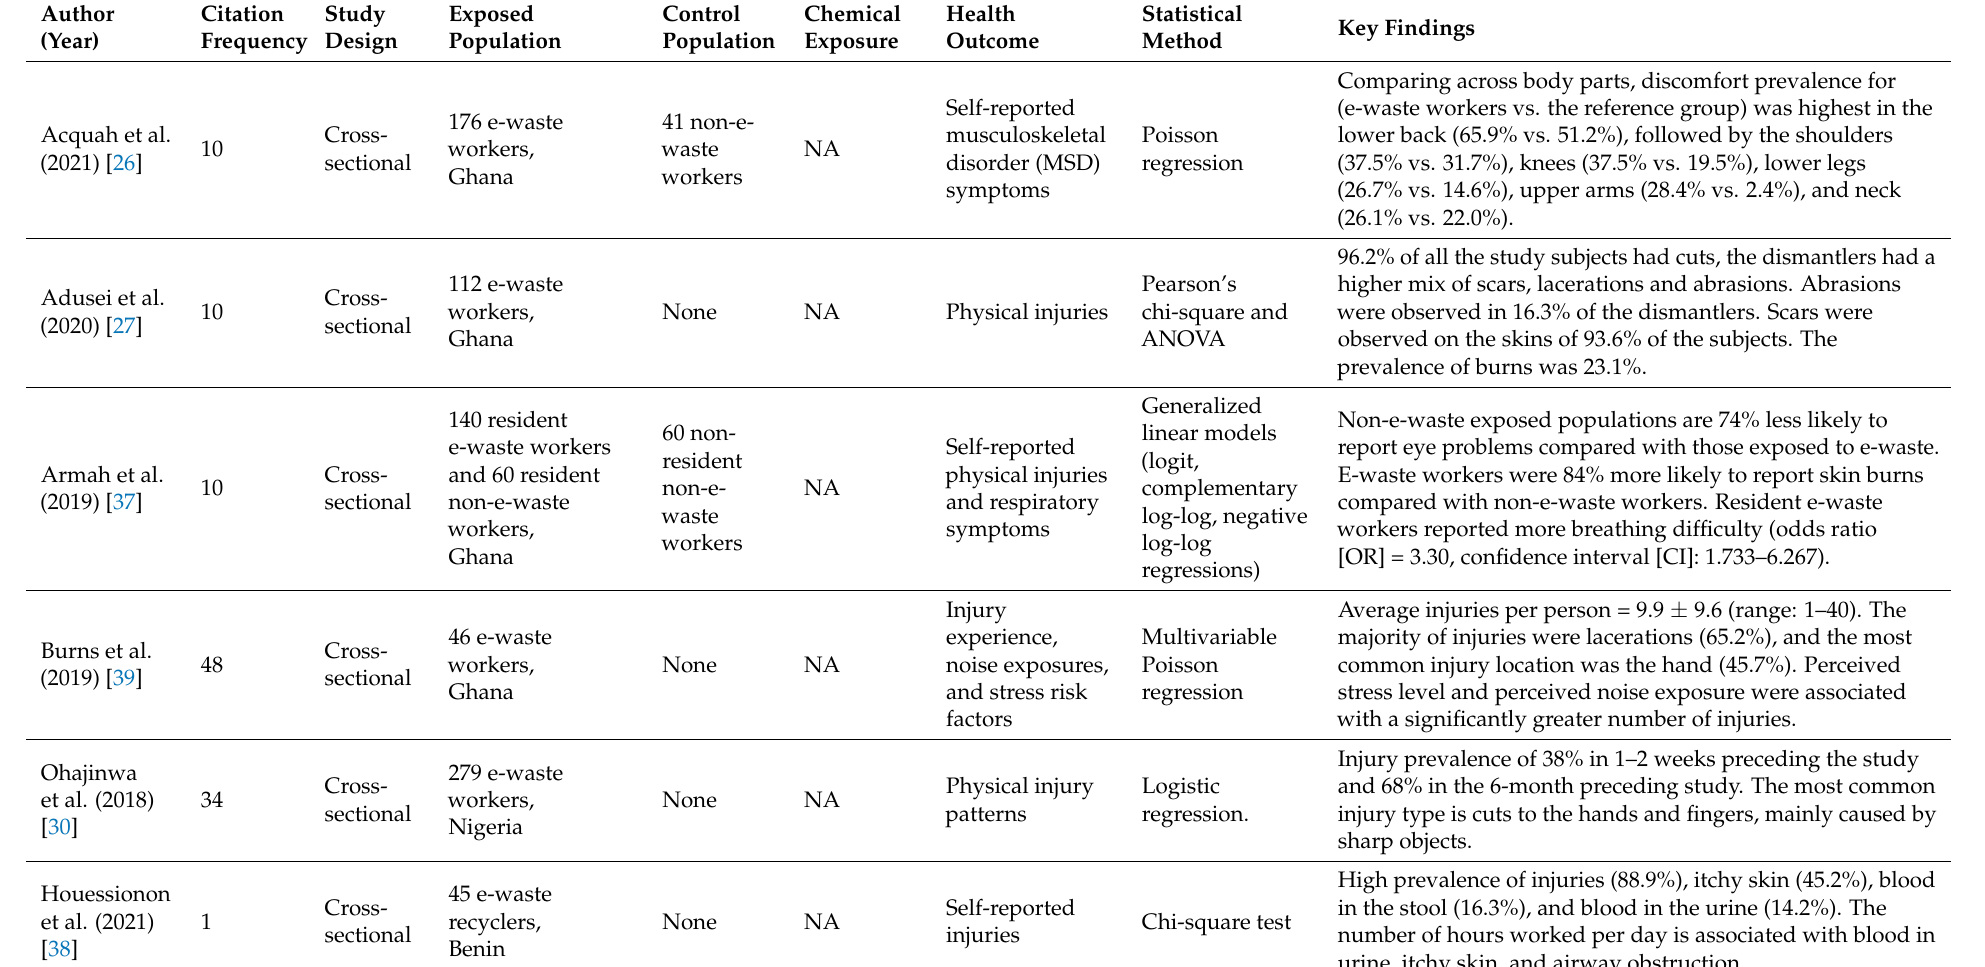
Table 1. Characteristics of included